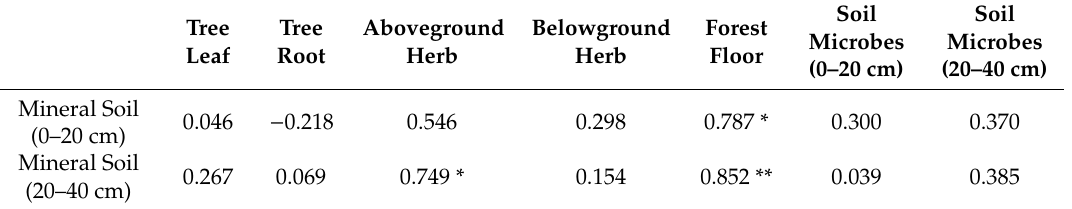
Table 3. The relationship among the di ff erent components C:P in P. asperata plantations. Tree Tree Aboveground Leaf Root Herb